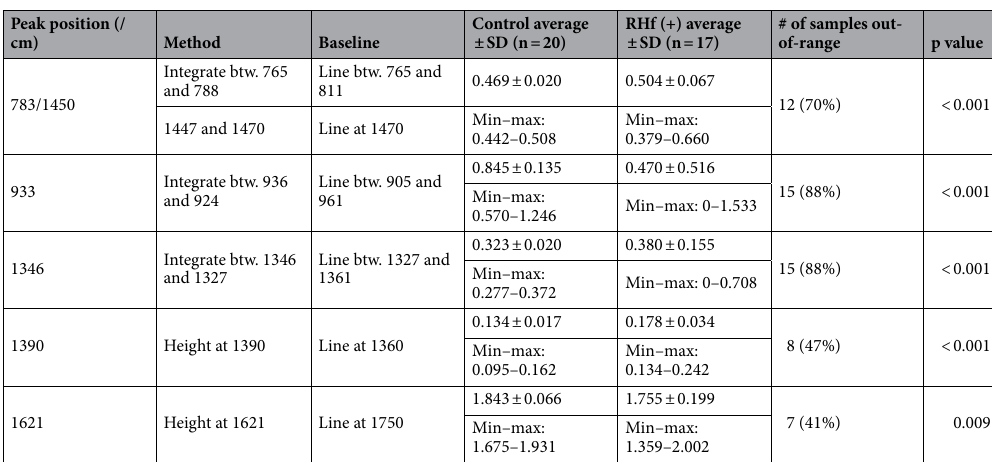
Table 2. Urine peak analysis summary. The number of out-of-range samples is determined based on the normal range defined by the control group min–max (limit) values. Statistical analysis was carried out using Mann Whitney U